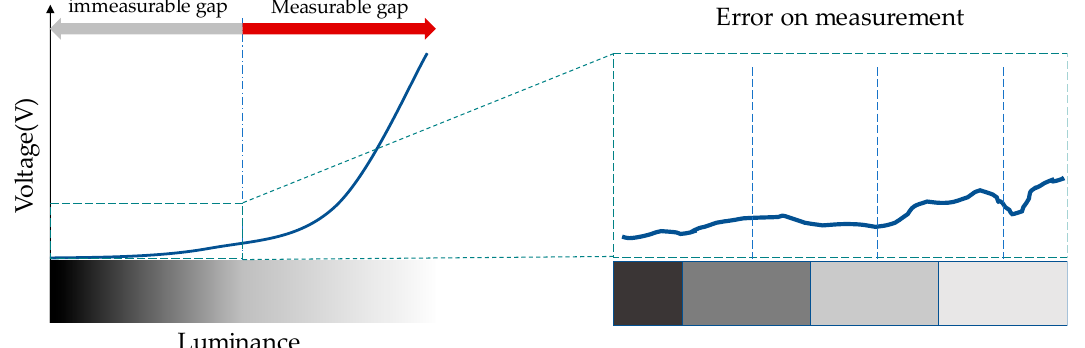
Figure 6. Measurement error and noise for an output voltage in the photodetector system.